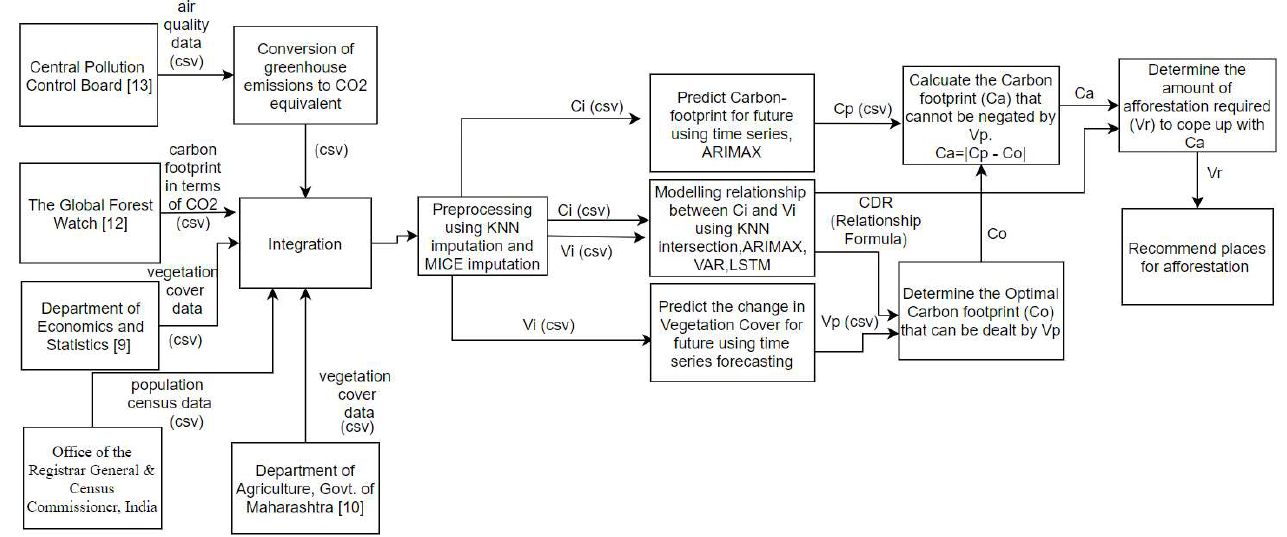
Fig. 2. Conceptual